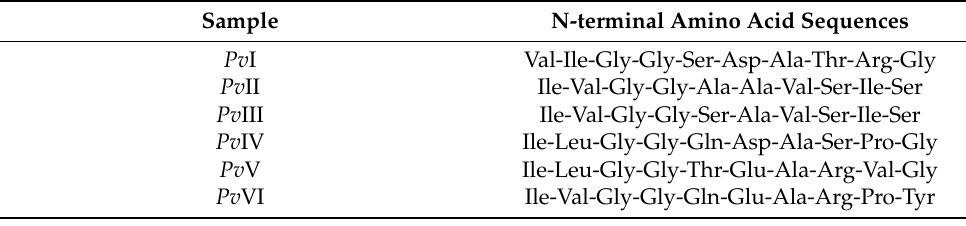
Table 4. N-terminal amino acid sequences of Pv I– Pv VI.